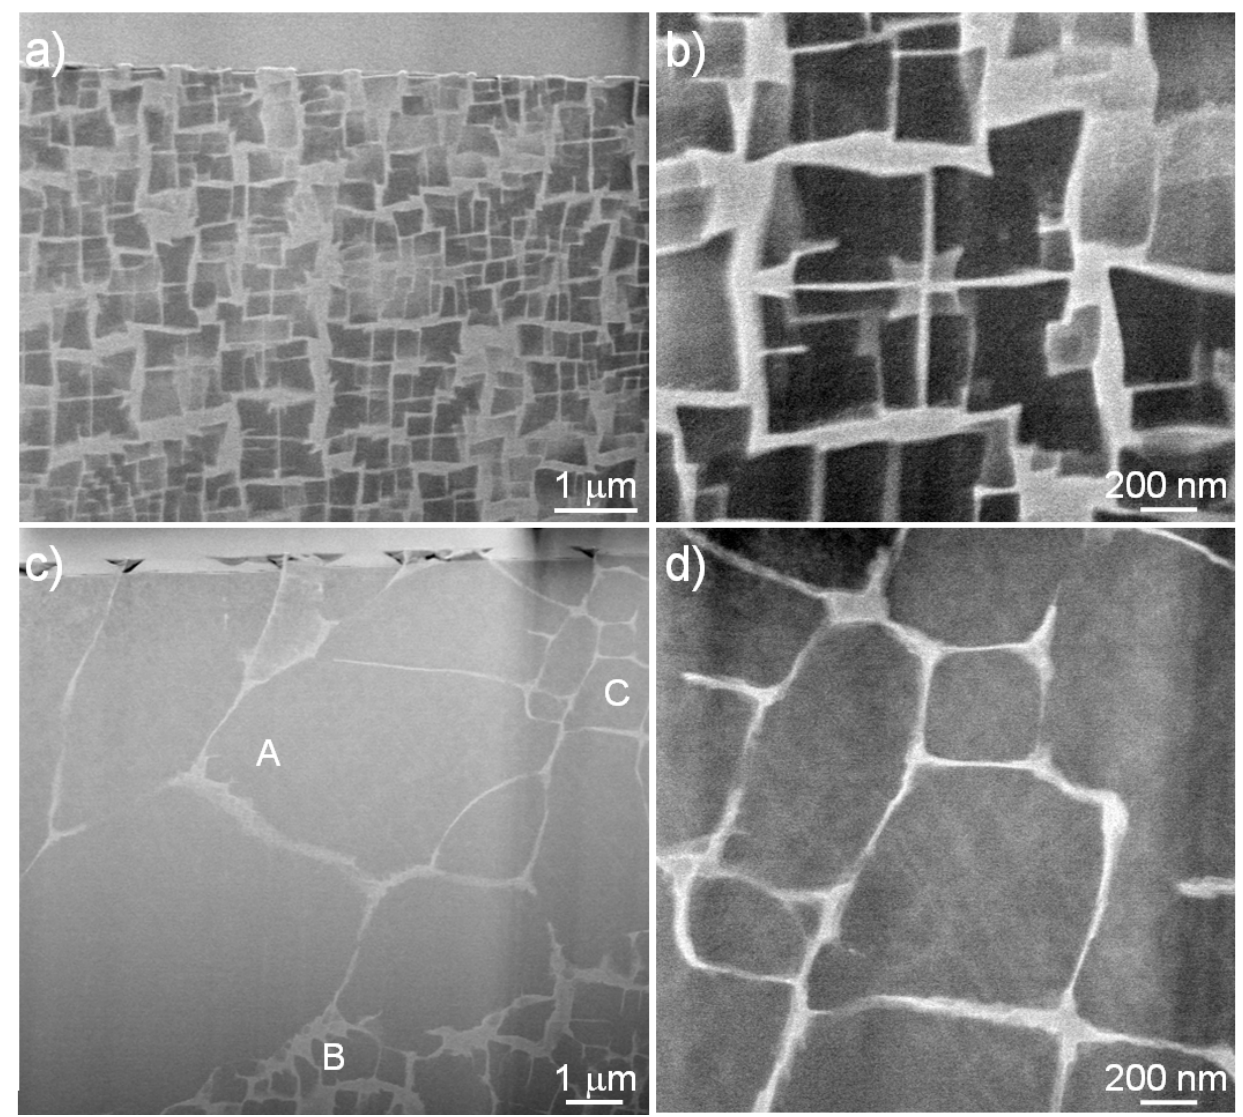
Figure 3. STEM ‐ HAADF images acquired from the dendrite core ( a , b ) and the interdendritic region ( c , d ) of a turbine blade. Note that in the interdendritic region, there are three different regions, which are marked as ‘A’, ‘B’, and ‘C’.